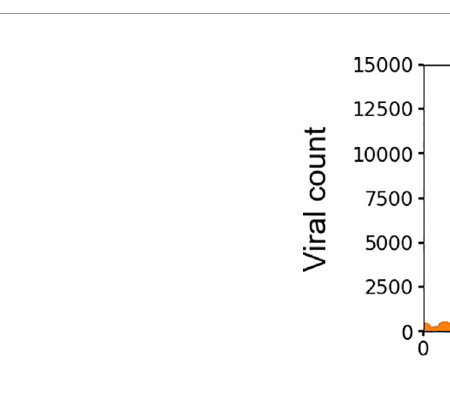
FIGURE 2 | Averaged concentration (n units x 10 3 /ml) of virus particles as a function of time during primary infections for both DENV-1 and DENV-2 from 10,000 simulations, error bars are shown as the standard